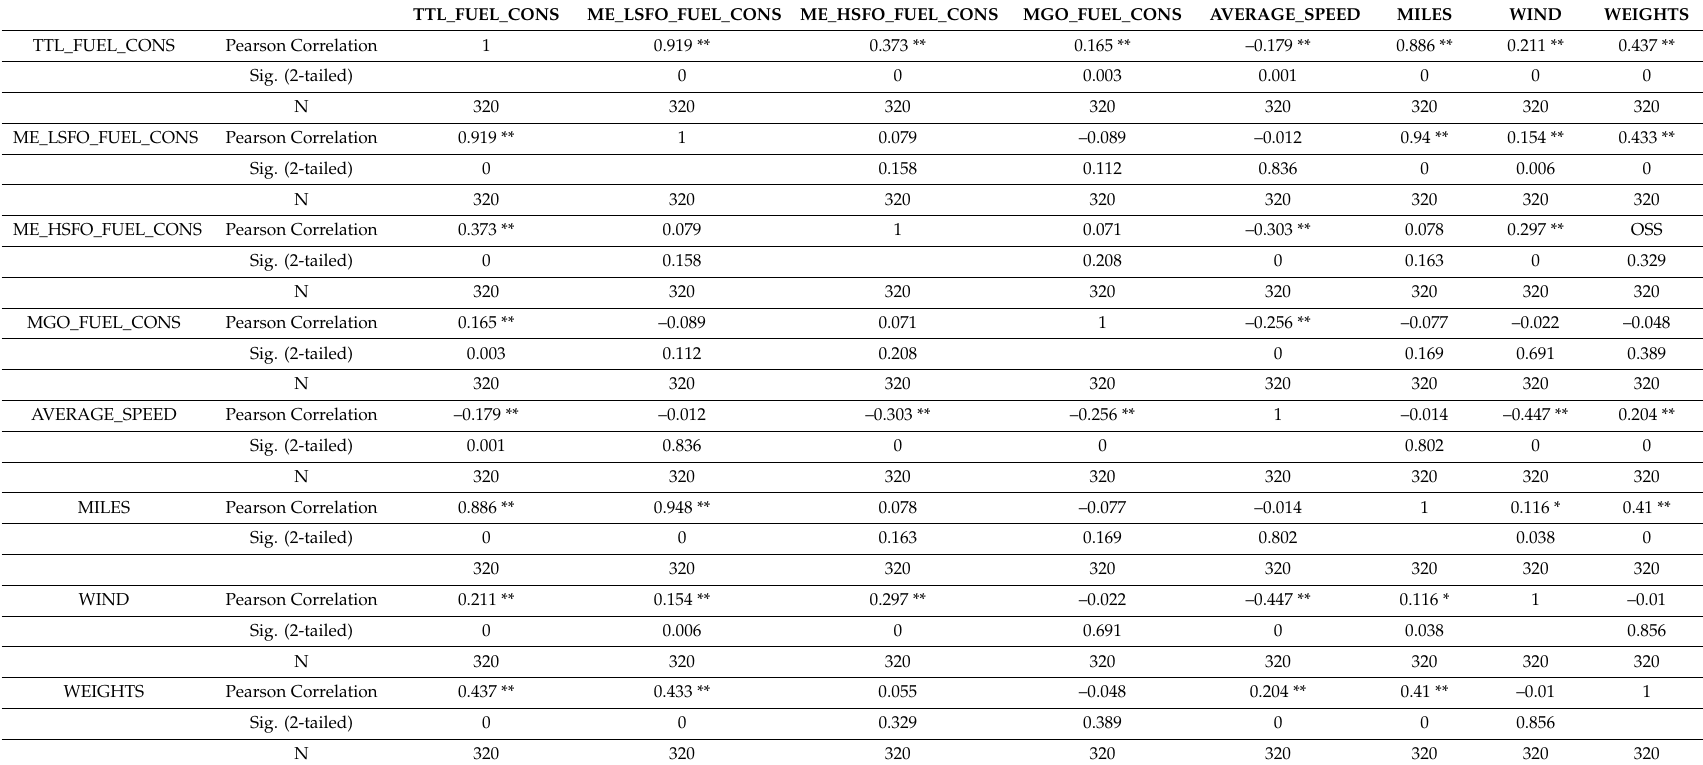
Table 2. Correlation analysis of fuel